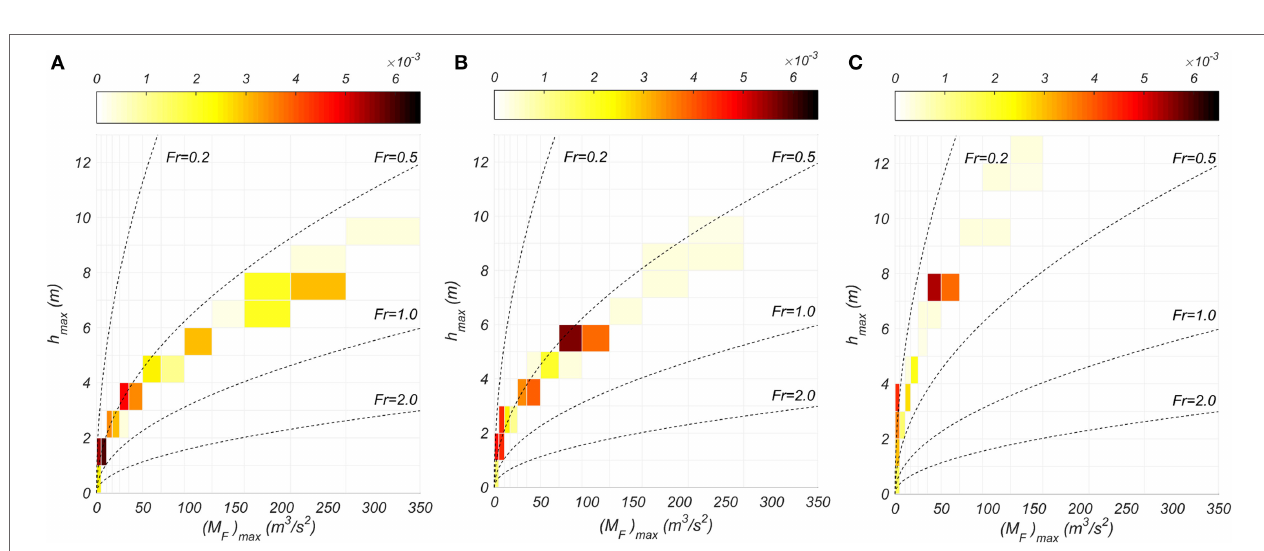
FIGURE 10 | Annual exceedance probability (AEP) of h max (A) and ( M F ) max (B) at Points 1 (black solid), 2 (red dash), and 3 (blue dash-dot).